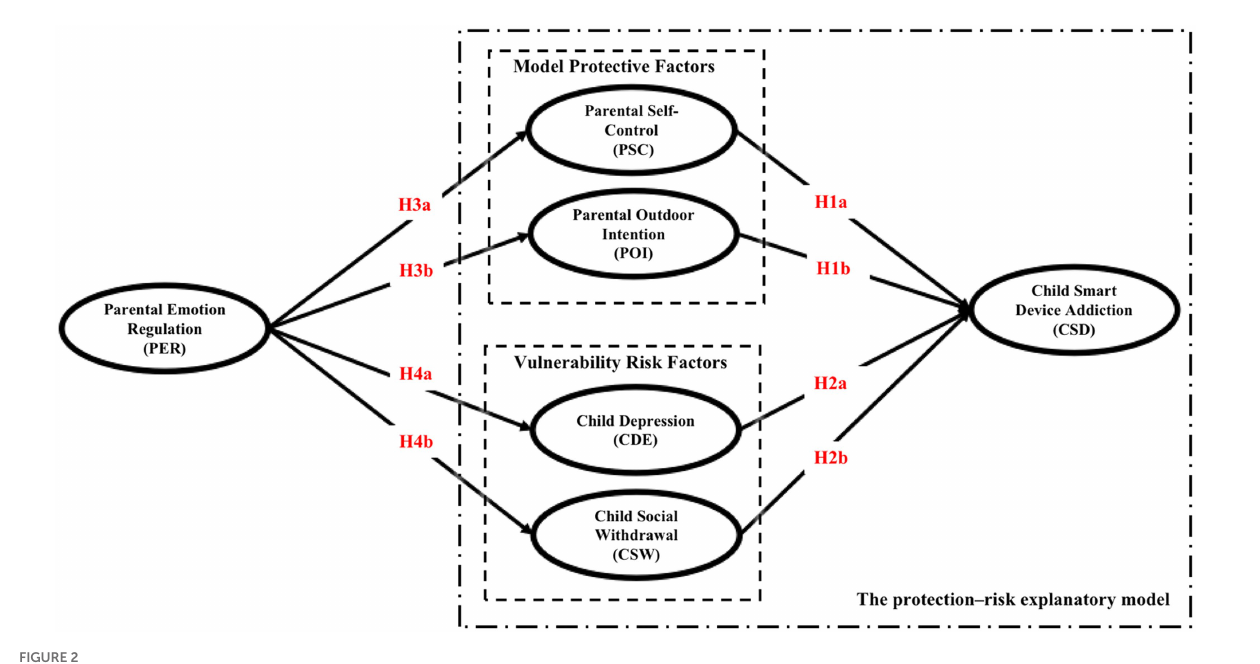
FIGURE 2 Proposed research